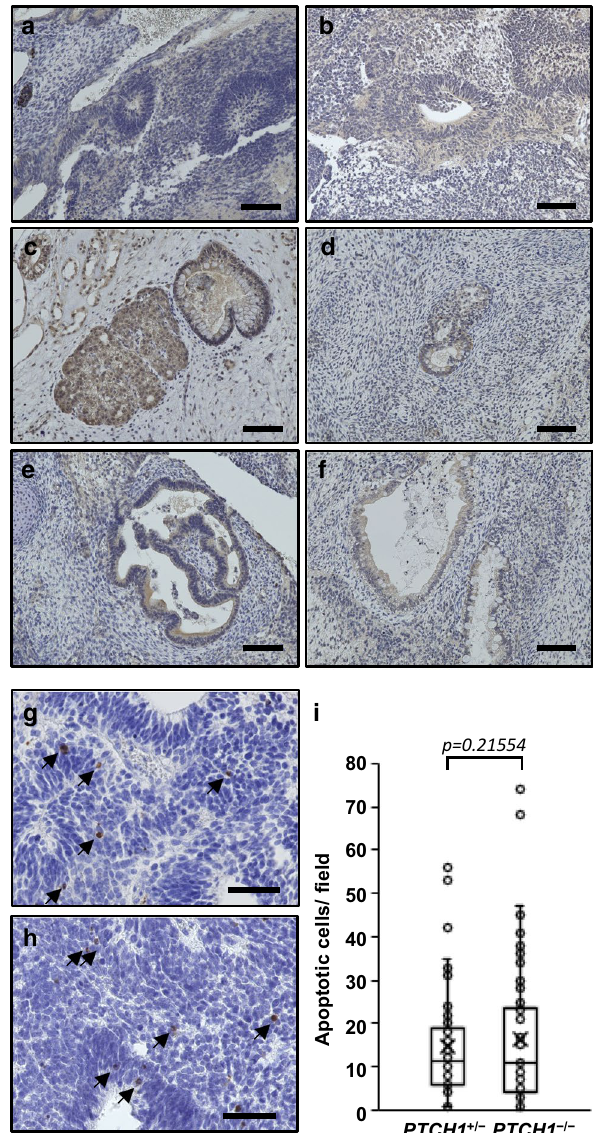
Fig. 5 The SHH expressions and apoptotic cells in terato- mas. a – f Immunohistological staining of SHH. SHH was expressed in neural tissues ( a , b ), glands c , d and intestinal epithelium e , f in PTCH1 +/− a , c and e and PTCH1 −/− teratomas ( b , d and f ). g – i Apoptosis in PTCH1 +/− g and PTCH1 −/− tera- toma ( h ). Cleaved caspase-3 positive apoptotic cells were indicated by allows. Numbers of apoptotic cells counted in each field were displayed in the boxplot ( i ). Open circles and cross signs indicate each value of apoptotic cells and the averages, respectively ( PTCH1 +/− ; n = 55, PTCH1 −/− ; n = 85). Scale bars: 100 μm in a – f , 50 μm in g and